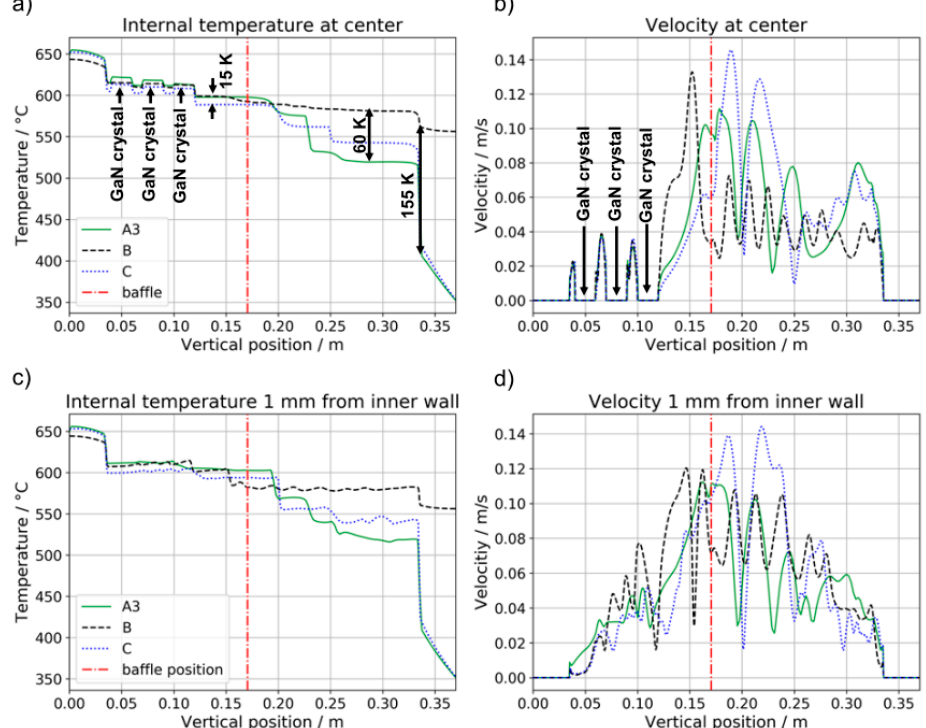
Figure 11. Comparison of internal temperatures ( a , c ) and flow velocities ( b , d ) depending on the method of boundary condition definition along the centerline of the autoclave ( a , b ) and in the vicinity of the inner autoclave wall ( c , d ). Regions with zero velocity originate from fully blocking solids.